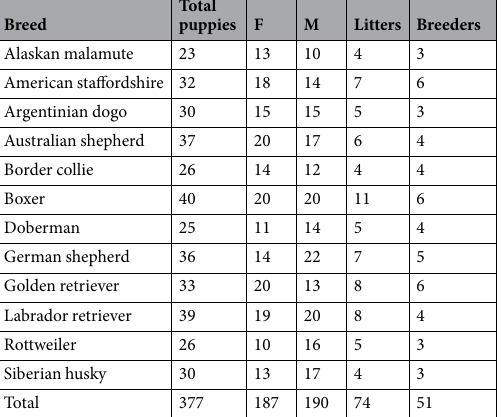
Table 2. Description of sample size. Total number of puppies per breed, sex, number of litters per breed and number of different breeders from which the litters came from.